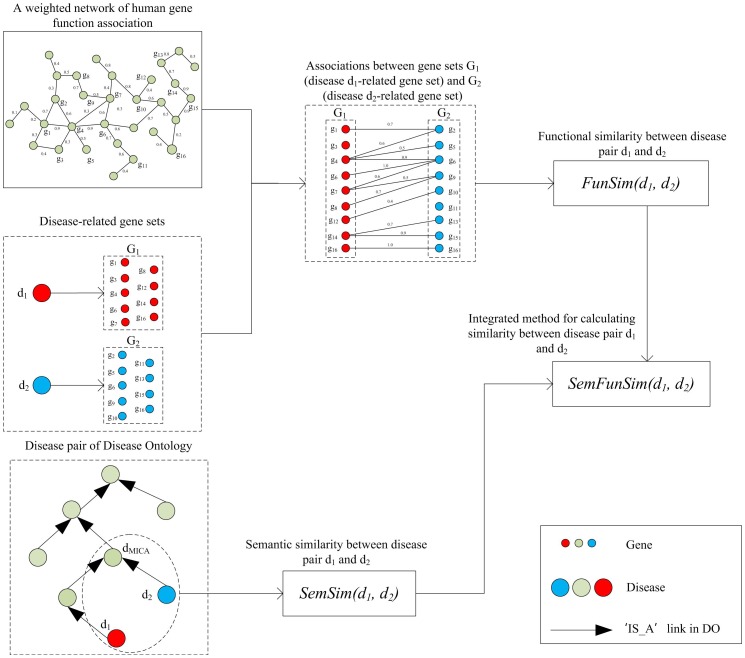
Overview of SemFunSim.d1, d2 are two diseases, and dMICA is the MICA of d1 and d2. G1, G2 and GMICA represent gene sets related to d1, d2 and dMICA, respectively.